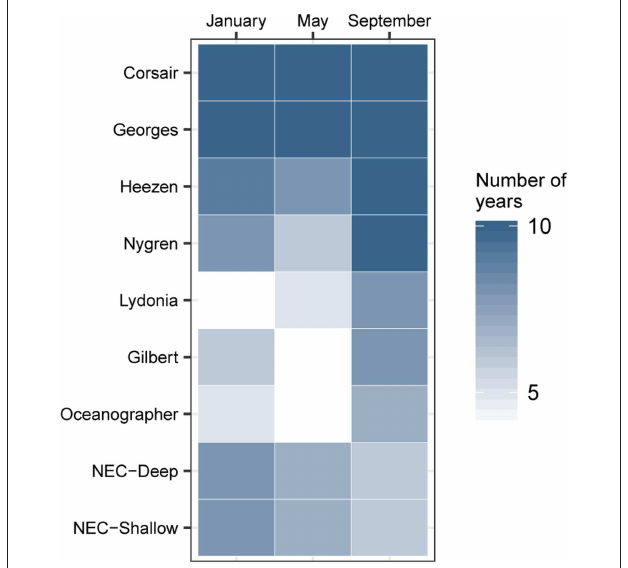
FIGURE 8 | Hydrodynamic connectivity based on occurrence (out of 10 years) observed between endpoints at the mouth of Corsair Canyon and zones of interest in January, May, and September between 2004 and 2013.